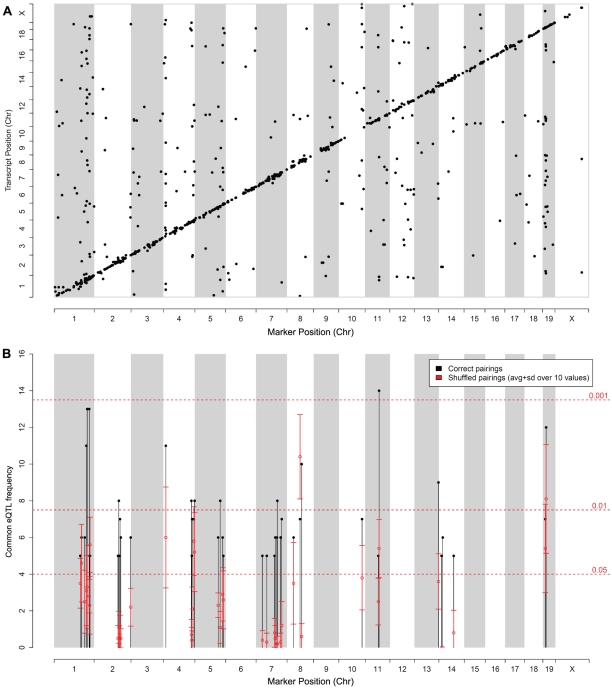
Co-localizing common eQTL between MDP and BXD datasets.The top 0.5% of all eQTL of the two datasets were compared using the ‘exact’ comparison and common eQTL are shown. A: matrix of common eQTL. X-axis shows marker positions and y-axis shows target gene positions. Each dot corresponds to an eQTL common between the two studies. B: Number of common eQTL across the genome within 1320 equally sized bins of 2 Mb. Black bars report the number of common eQTL in each bin, whereas the red error bars represent the mean number and standard deviation of hits in each bin obtained after shuffling the probesets (10 randomizations). Horizontal red lines represent global p-values obtained after shuffling bin positions. Results are shown for bins with at least 5 common eQTL.